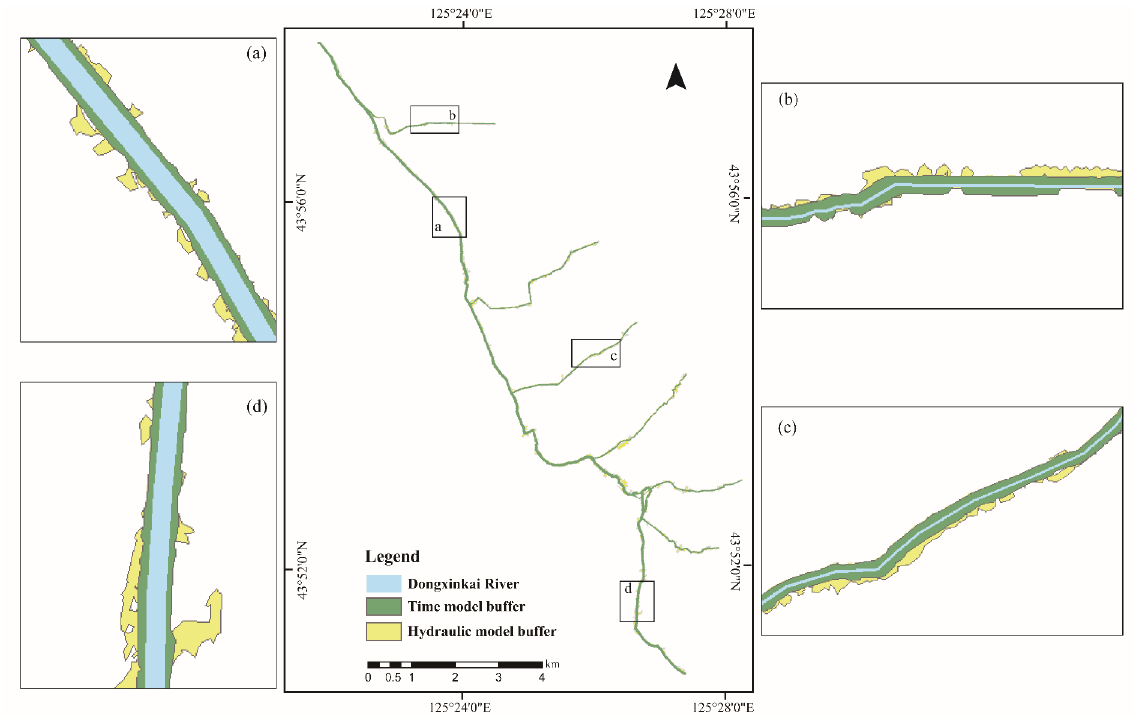
Figure 7. Delimited VBZ boundaries for time model and hydraulic model. ( a – d ) are zoomed in on specific areas. Table 4. Normal VBZ width of DX